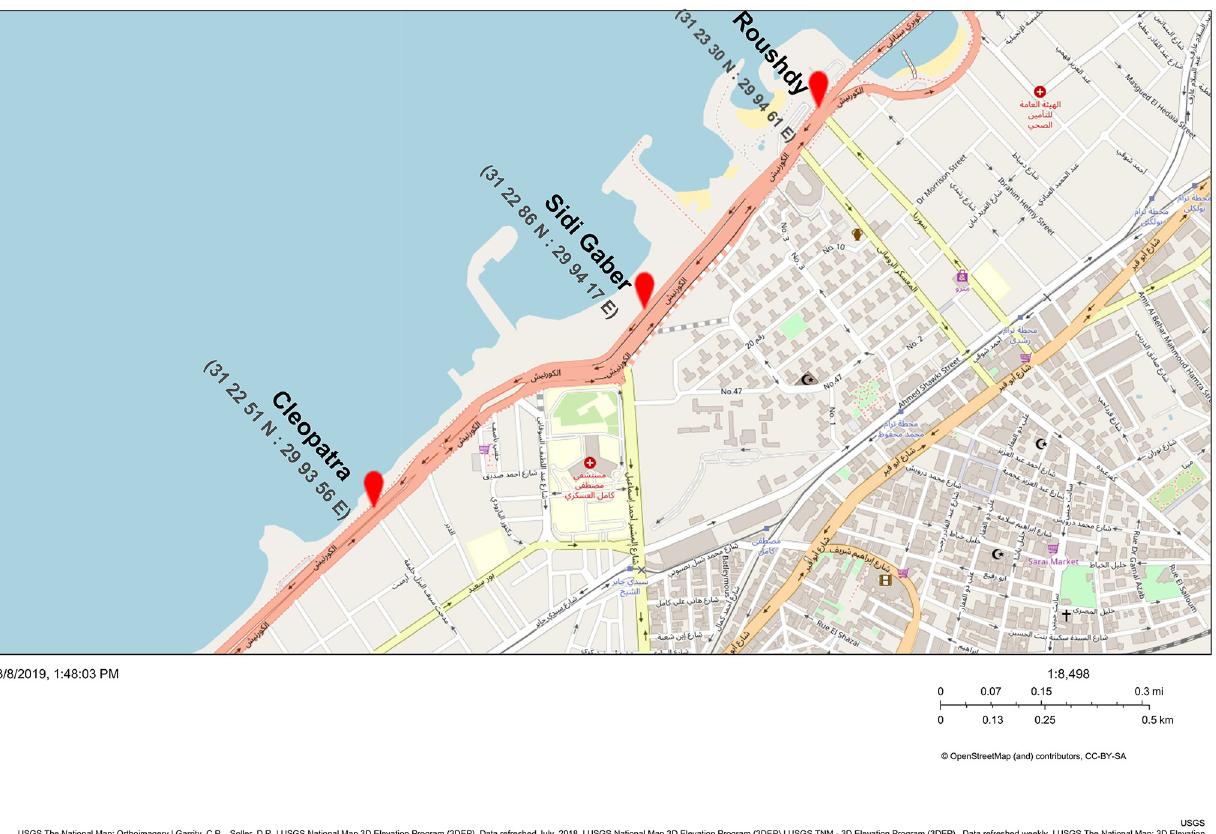
Fig 5. The three selected stations along Elgiesh Roadway in Alexandria City, Egypt. (The National Map Advanced Viewer, 2019).